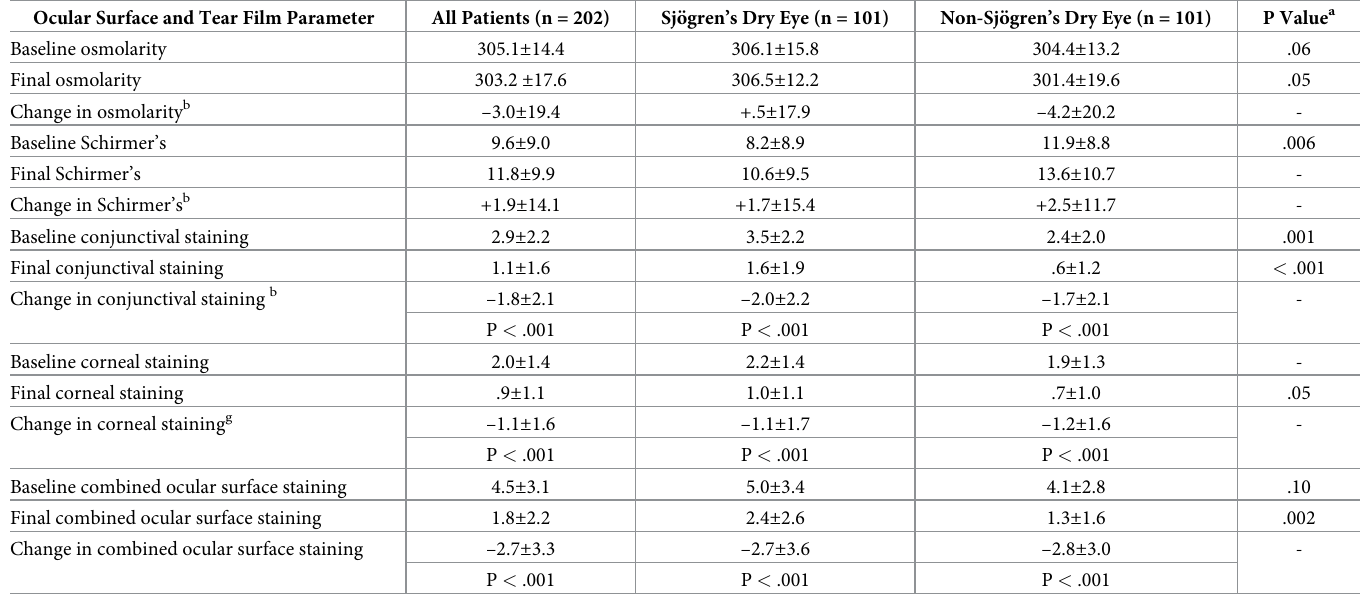
Table 3. Baseline and final objective dry eye parameters for a longitudinal, clinic-based sample of patients with Sjo¨gren’s and non-Sjo¨gren’s dry eye